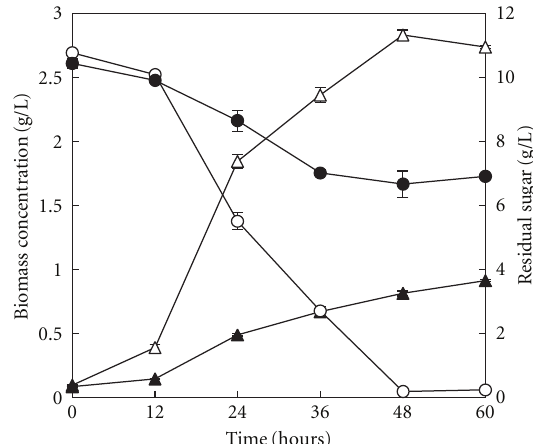
Figure 2: Cell growth and sugar consumption of Chlorella pyrenoidosa in the glucose medium and the rice straw hydrolysate (RSH) medium. Biomass concentration ( (cid:2) ) and residual sugar concentration ( • ) in the glucose medium; biomass concentration (cid:2) ( ) and residual sugar concentration ( (cid:3) ) in the RSH medium. Error bars = mean ± standard